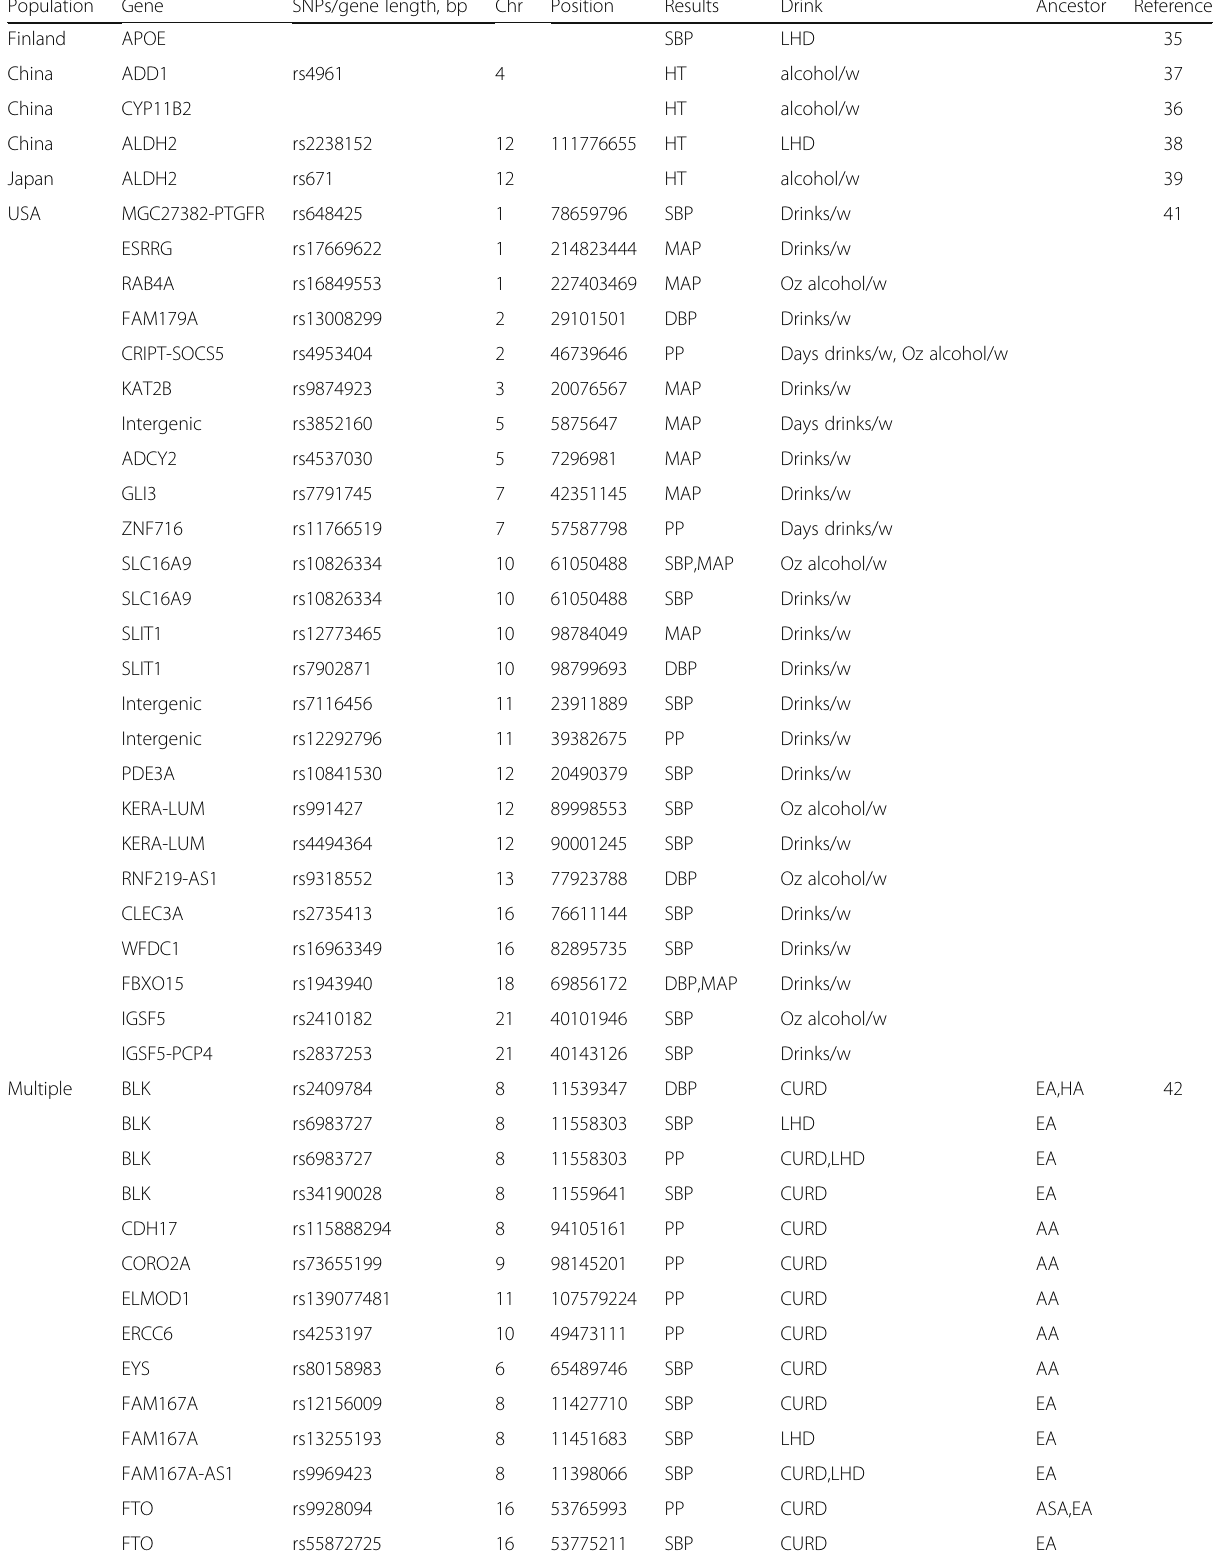
Table 4 Review for interaction of gene and alcohol intake on